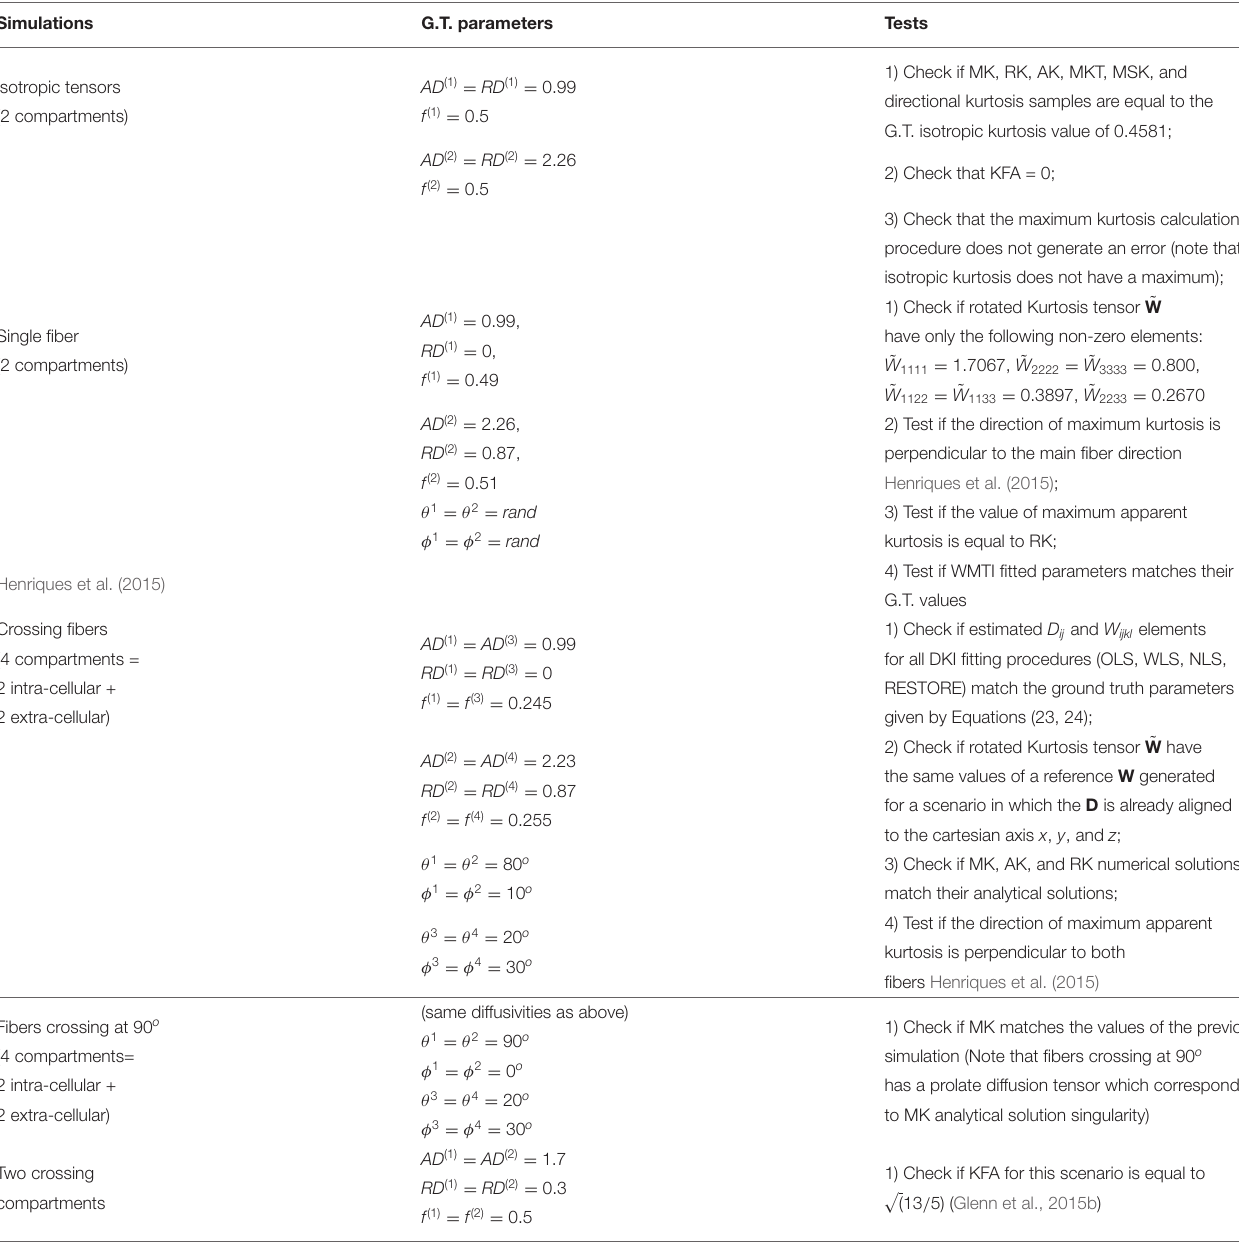
TABLE 1 | Details of numerical simulations used for DKI Unit Testing Numerical-a brief description of each simulations, the simulation compartmental diffusion parameters (where AD ( m ) , RD ( m ) , f ( m ) , φ ( m ) , and θ ( m ) are the axial diffusivity, radial diffusivity, water fraction, polar orientation angle and azimuthal orientation angle of a given compartment m ), and the checks preformed are presented on the left, middle and right columns,